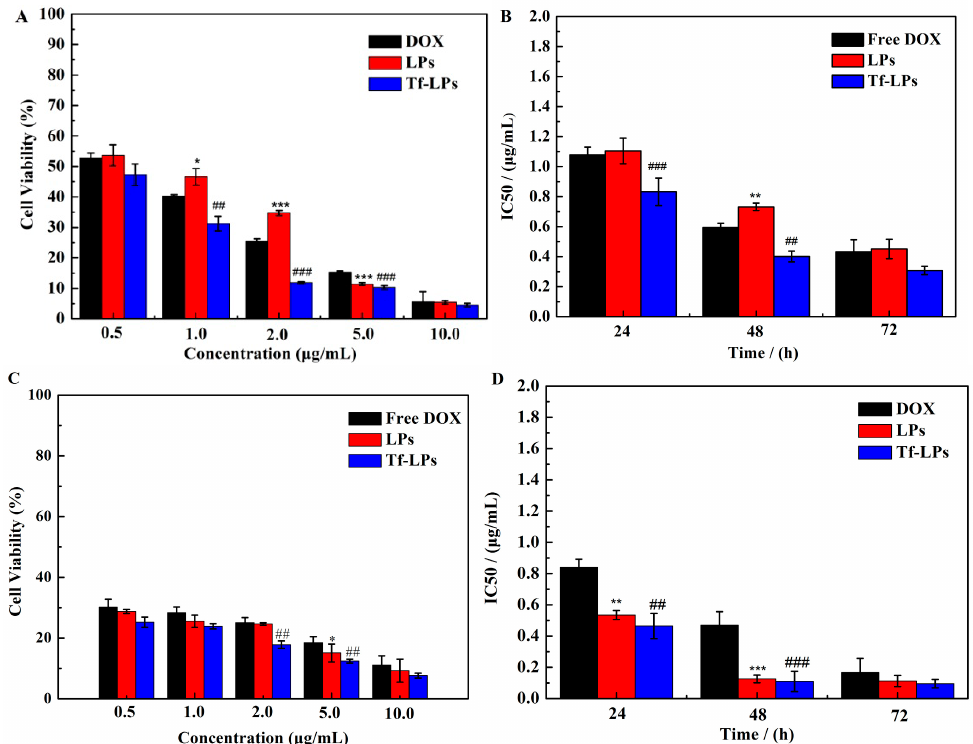
Figure 7. Antitumor activity of free DOX, LPs, and Tf-LPs. ( A ) Viability of U87 cells treated with free DOX, LPs and Tf-LPs for 48 h, ( B ) IC 50 values of three formulations for U87 cells at 24, 48 and 72 h, ( C ) Viability of GL261 cells treated with free DOX, LPs and Tf-LPs for 48 h, and ( D ) IC 50 values of three formulations on GL261 cells at 24, 48 and 72 h ( n = 6). * p < 0.05, ** p < 0.01, *** p < 0.001, LPs versus free DOX; ## p < 0.01, ### p < 0.001, Tf-LPs versus free DOX. The antitumor activity of Tf-LPs was higher than LPs and free DOX. Abbreviations: LPs, DOX-loaded liposomes; Tf-LPs, DOX-loaded